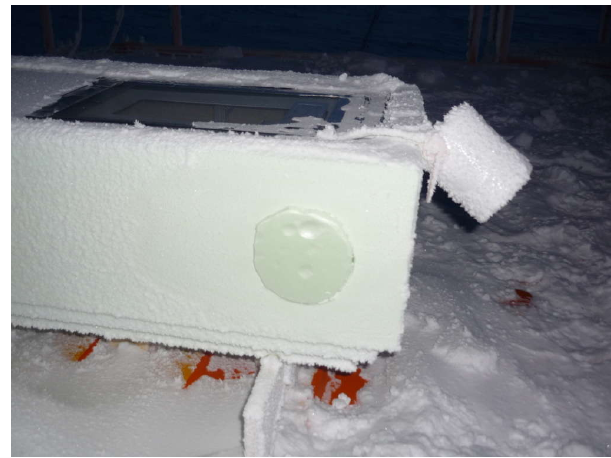
Figure 6. ICE-CAMERA at − 70 ◦ C, Concordia station, winter: the DS if free of